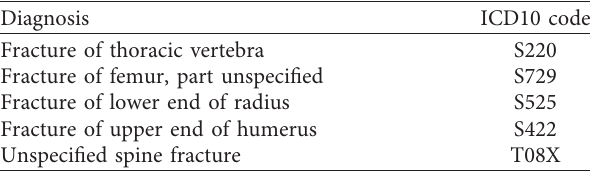
Table 1: ICD 10 codes used for the diagnosis of fragility